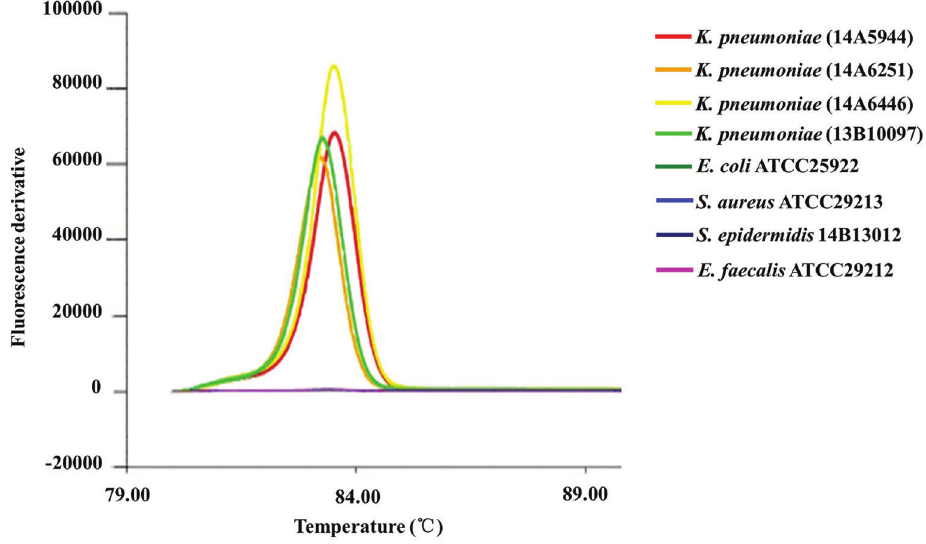
Figure 3. The melt curve in loop-mediated isothermal ampli fi cation (LAMP) speci fi city reaction tubes. Speci fi city of the LAMP assay for detecting the target gene of ureR_1 by Genie s II. Genomic DNA of K. pneumoniae was used as the template for LAMP test. All experiments were repeated